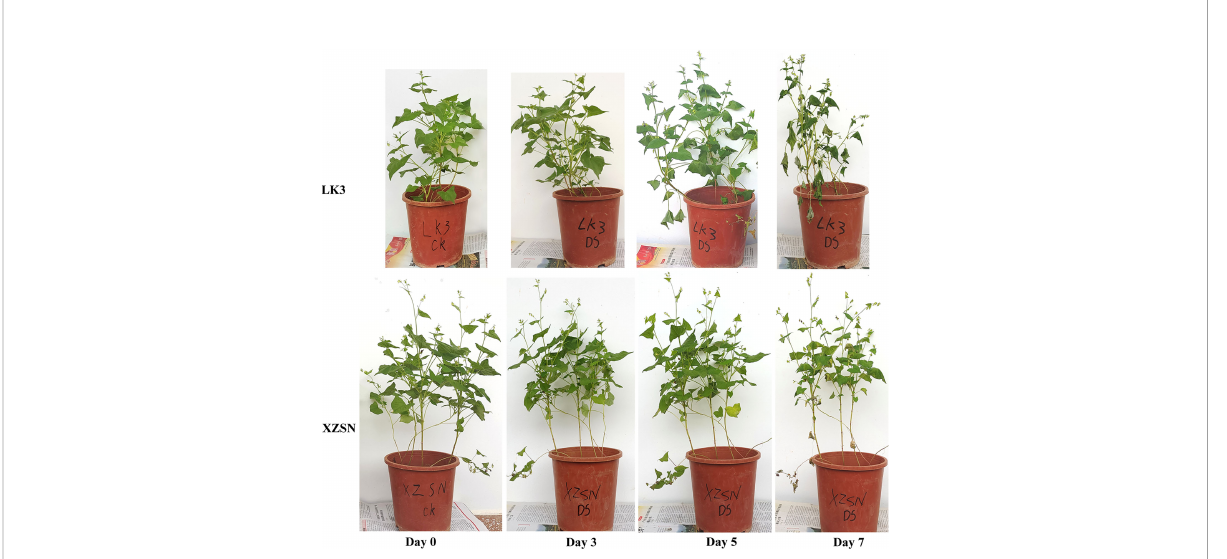
FIGURE 1 Phenotypic response of the drought-tolerant genotype XZSN and the drought-susceptible genotype LK3. Days 0, 3, 5, and 7 represent natural drought stress conditions by withholding water for 0, 3, 5, and 7 days after pouring suf fi cient water,